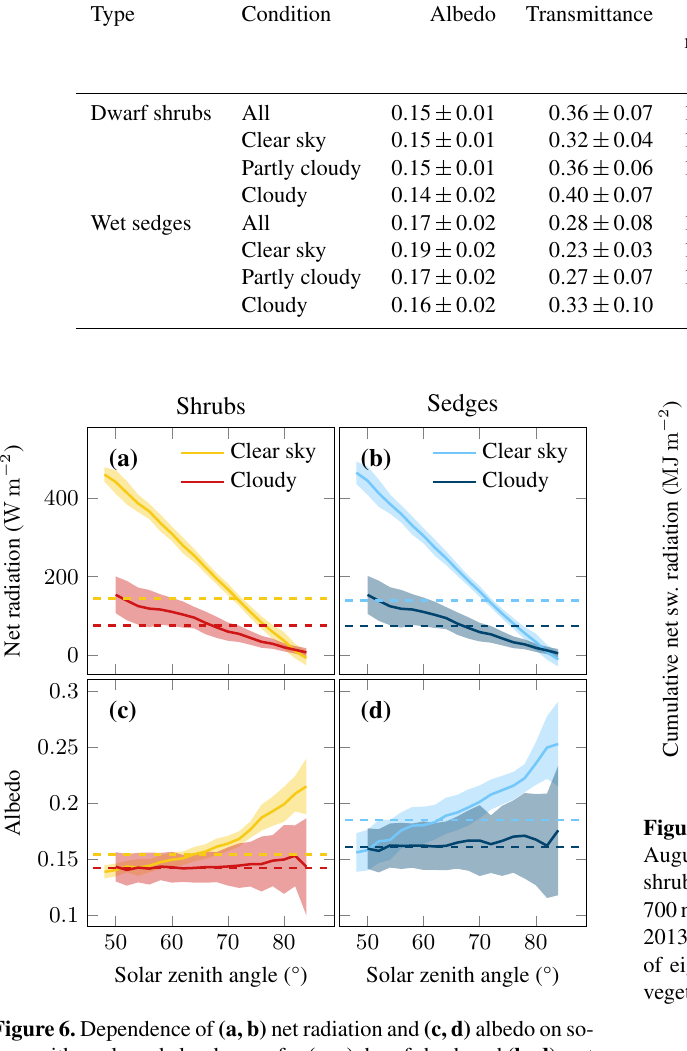
Figure 6. Dependence of (a, b) net radiation and (c, d) albedo on so- lar zenith angle and cloud cover for (a, c) dwarf shrub and (b, d) wet sedge, growing season mean ± standard deviation values calculated for 2 ◦ intervals; the dashed lines represent the mean diel value under each condition.